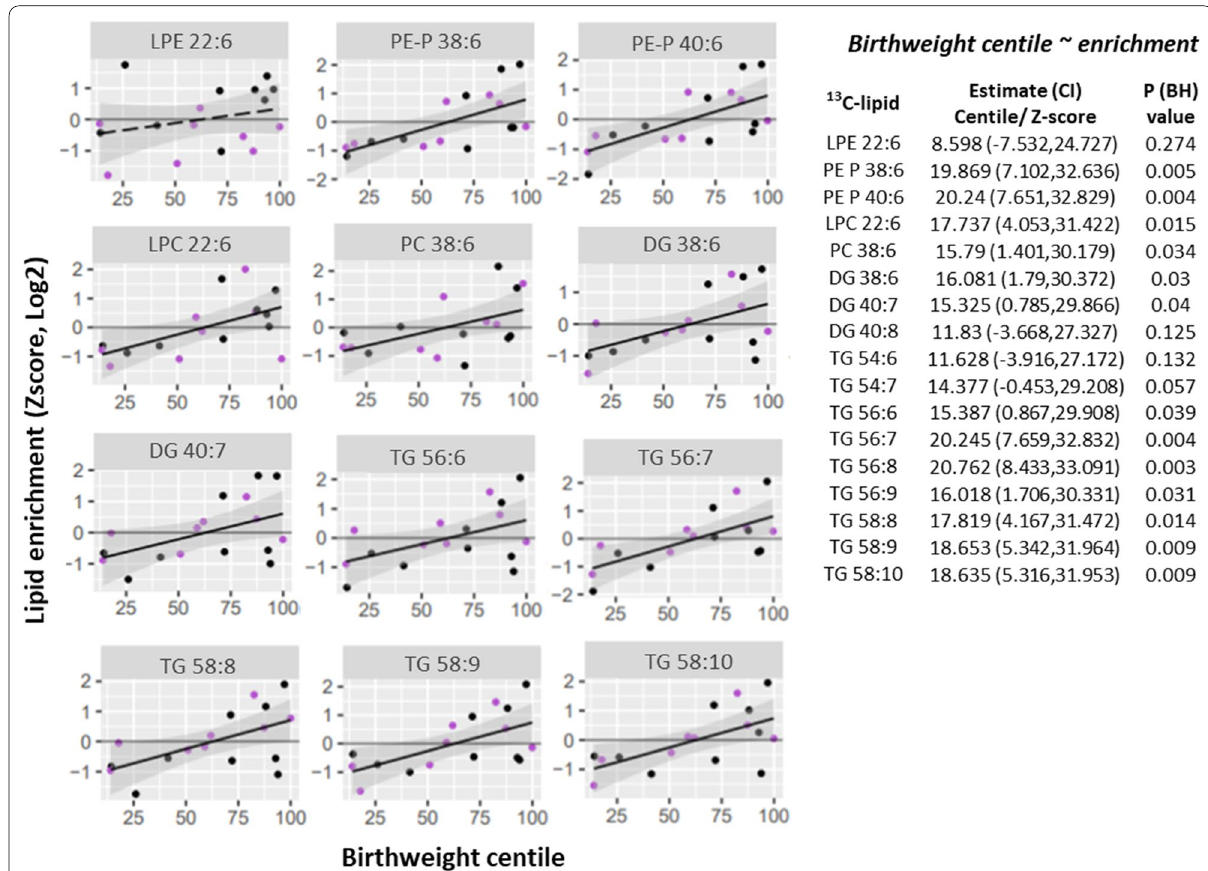
Fig. 4 Positive associations between placental 13 C‑DHA‑lipid enrichment (Z‑score, log2) and birthweight centile. Linear regression was run with birthweight centile as the outcome and either lipid amount or lipid enrichment as the predictor. The Benjamini–Hochberg method was used to correct for multiple testing. Solid lines show significant associations while dashed lines show non‑significant results. Shaded areas show 95% confidence intervals. Key—Purple: non‑GDM, Black: GDM. BH Benjamini–Hochberg, CI confidence interval, DG diacylglycerol, DHA docosahexaenoic acid, GDM gestational diabetes, LPC lyso‑phosphatidylcholine, LPE lyso‑phosphatidylethanolamine, PC phosphatidylcholine, PE-P phosphatidylethan olamine‑plasmalogen, TG